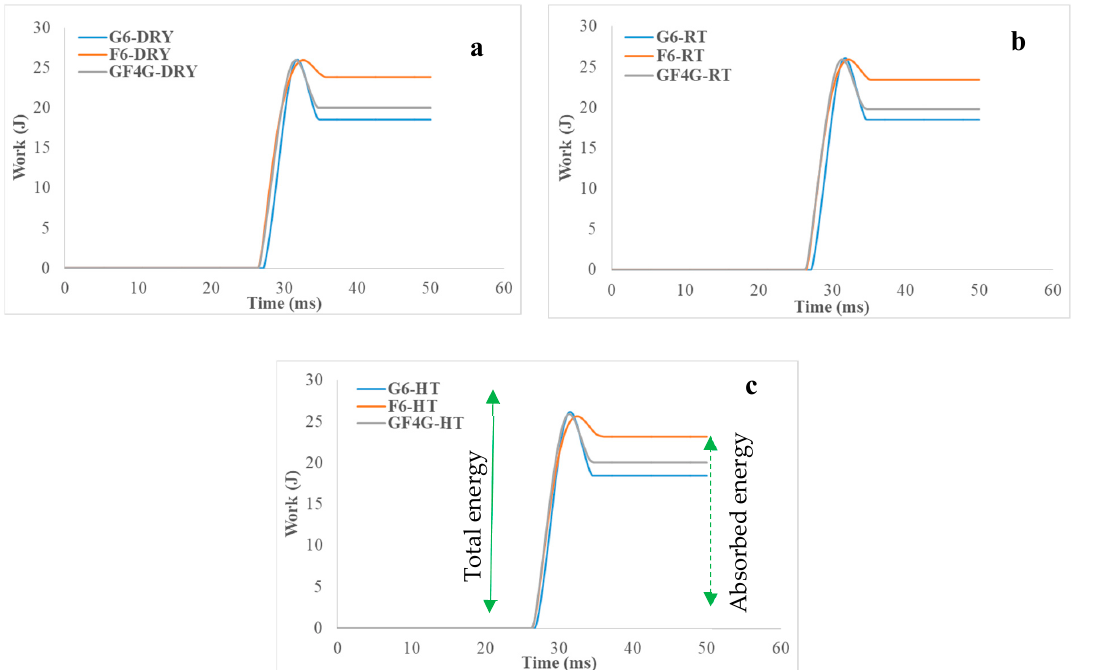
Figure 4. Work versus time traces for ( a ) dry samples, ( b ) room temperature wet samples and ( c ) high temperature wet samples. Table 4. Maximum work and maximum time of dry samples, RT and HT wet samples.